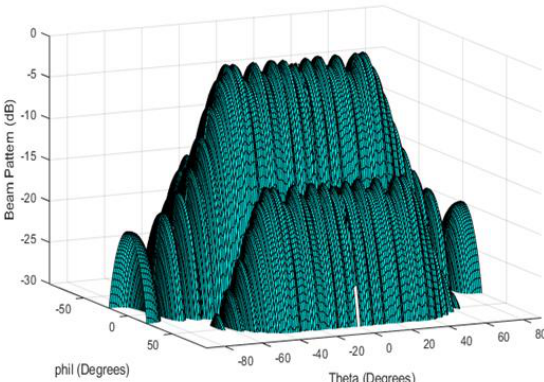
Figure 8. Two-dimensional theoretical beam pattern of the 5 × 55 conformal array compared with those from the FEA: ( a ) M-subarray part; ( b ) N-subarray part.